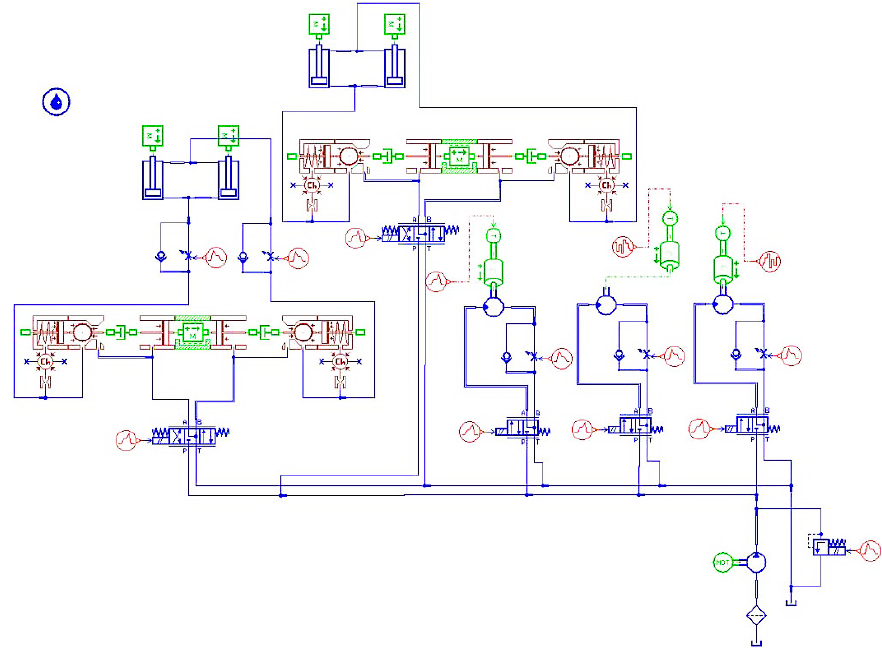
Figure 1. Hydraulic system simulation model of a combine harvester. Table 1. Main component simulation parameters.